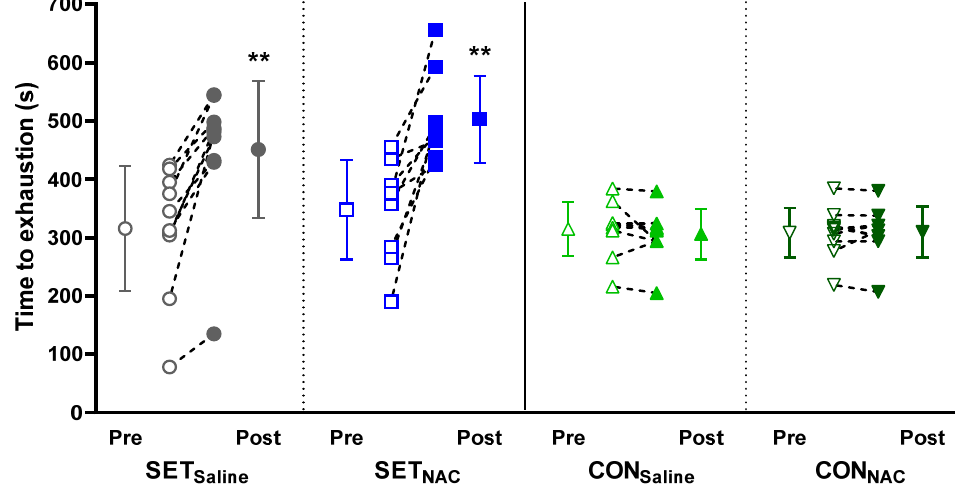
Figure 2. Leg exercise performance without and with N -acetylcysteine infusion before and after speed endurance training (SET). Time to exhaustion during knee-extensor exercise without (SET Saline , n = 10) and with N -acetylcysteine (SET NAC , n = 9) infusion before (Pre) and after (Post) SET as well as before and after habitual lifestyle maintenance (CON) for the right (CON Saline , n = 10) and left (CON NAC , n = 10) leg. ** Post different from Pre ( p < 0.01). Data are presented as mean ± SD with individual changes.